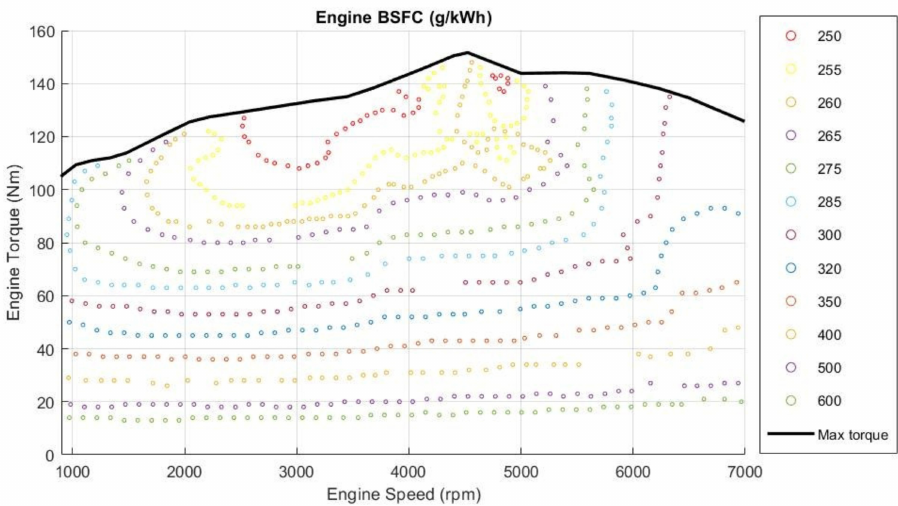
Figure 1. Engine’s full load torque and Brake-specific fuel consumption